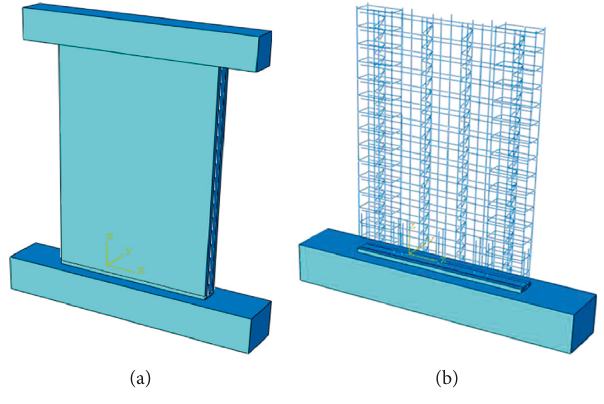
Figure 7: Finite element model of